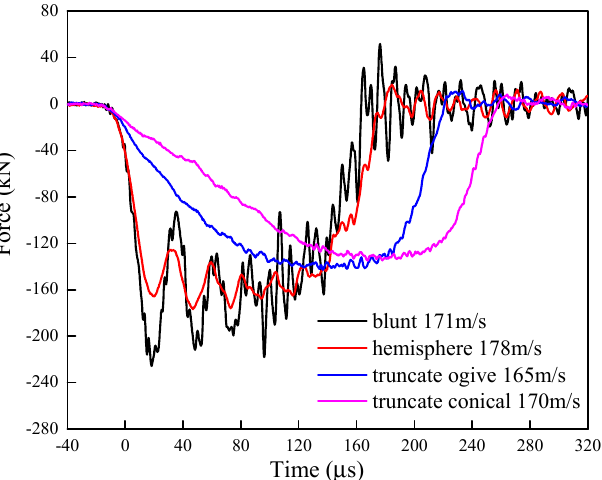
Figure 18. Impact load curve comparison for the different nose-shape projectiles at similar impact velocities.